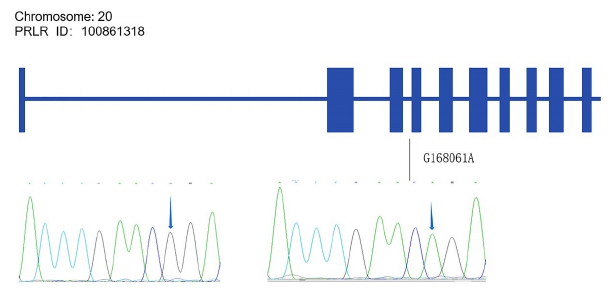
Figure A2. Partial chromatogram of SNP locus of PRLR gene in Liaoning cashmere